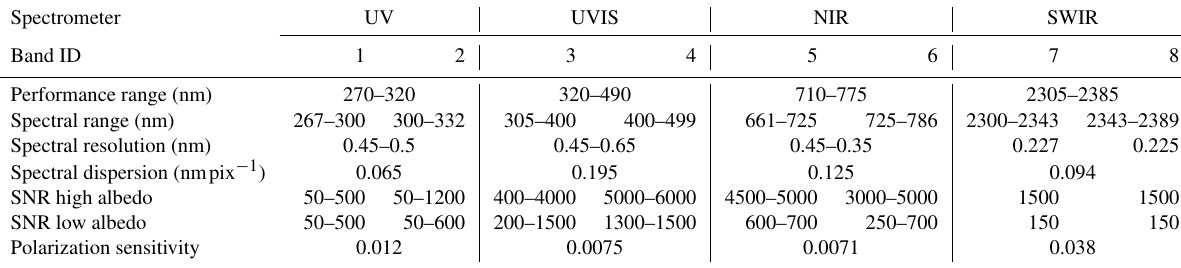
Table 1. Main spectral characteristics of the four TROPOMI spectrometers and the definition of the TROPOMI spectral bands with identifiers 1–8. The listed values are based on on-ground calibration measurements and valid at the detector centre. The performance range is the range over which the requirements are validated; the full range in general is larger. The listed signal-to-noise ratio (SNR) values are given for the nominal measurement configuration for a mid-latitude reference spectrum. Both the high- and low-albedo SNR values over the spectral range including absorption lines are